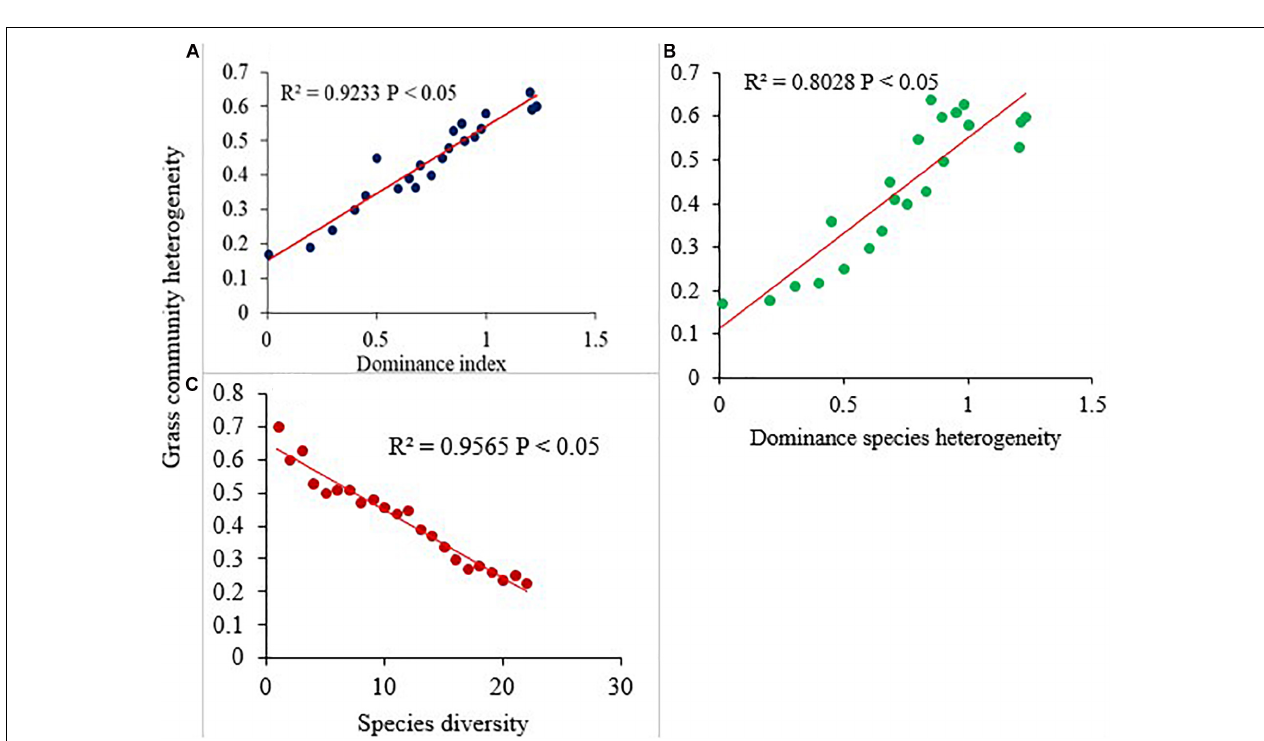
FIGURE 6 | The relationships of dominance index (A) , species diversity (B) , and dominant species heterogeneity (C) with grass community heterogeneity within the study